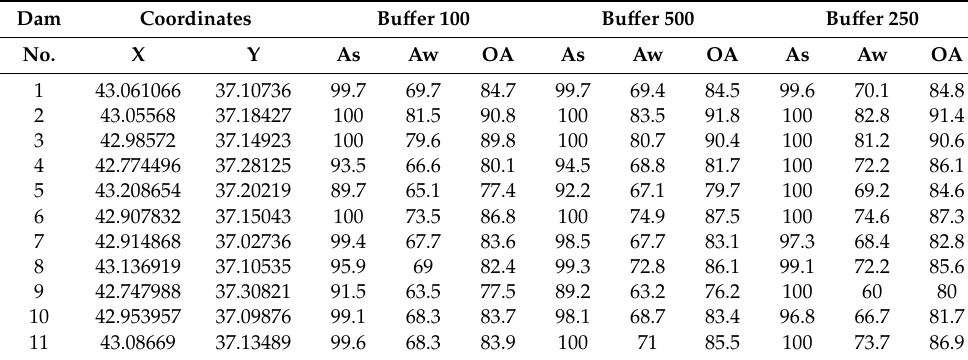
Table 5. Suggested dam’s coordinates, the accuracy of the suitable pixels by number (AS), the accuracy of the suitable pixel by weight (AW), and the overall accuracy (OA) of dam site suggested using AHP model.